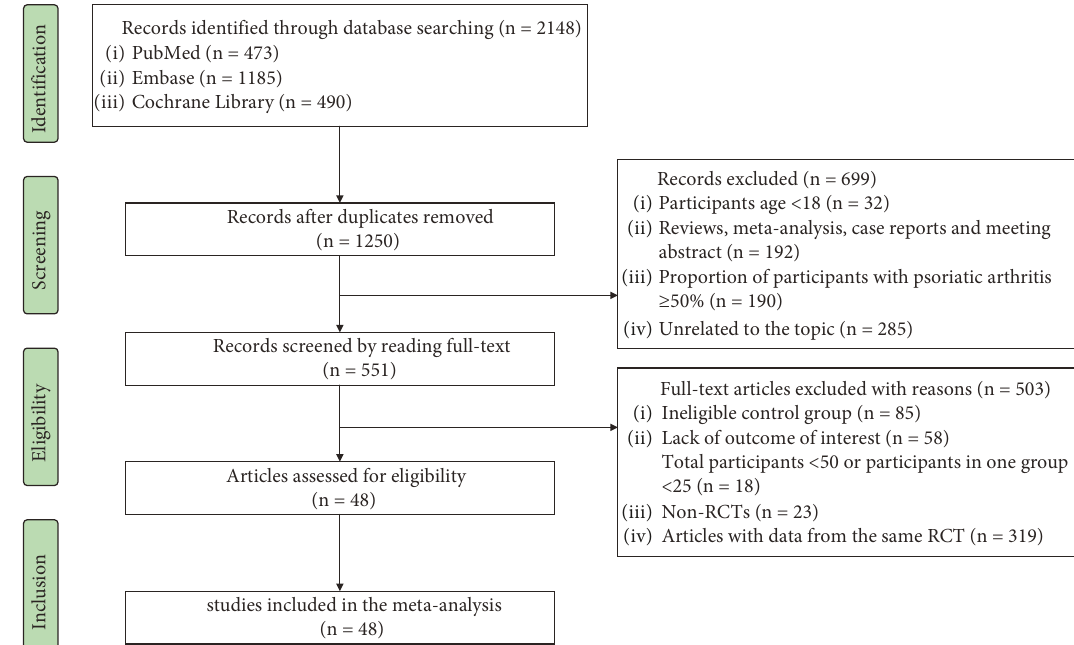
Figure 1: PRISMA flowchart of randomized controlled trials (RCTs) included in the